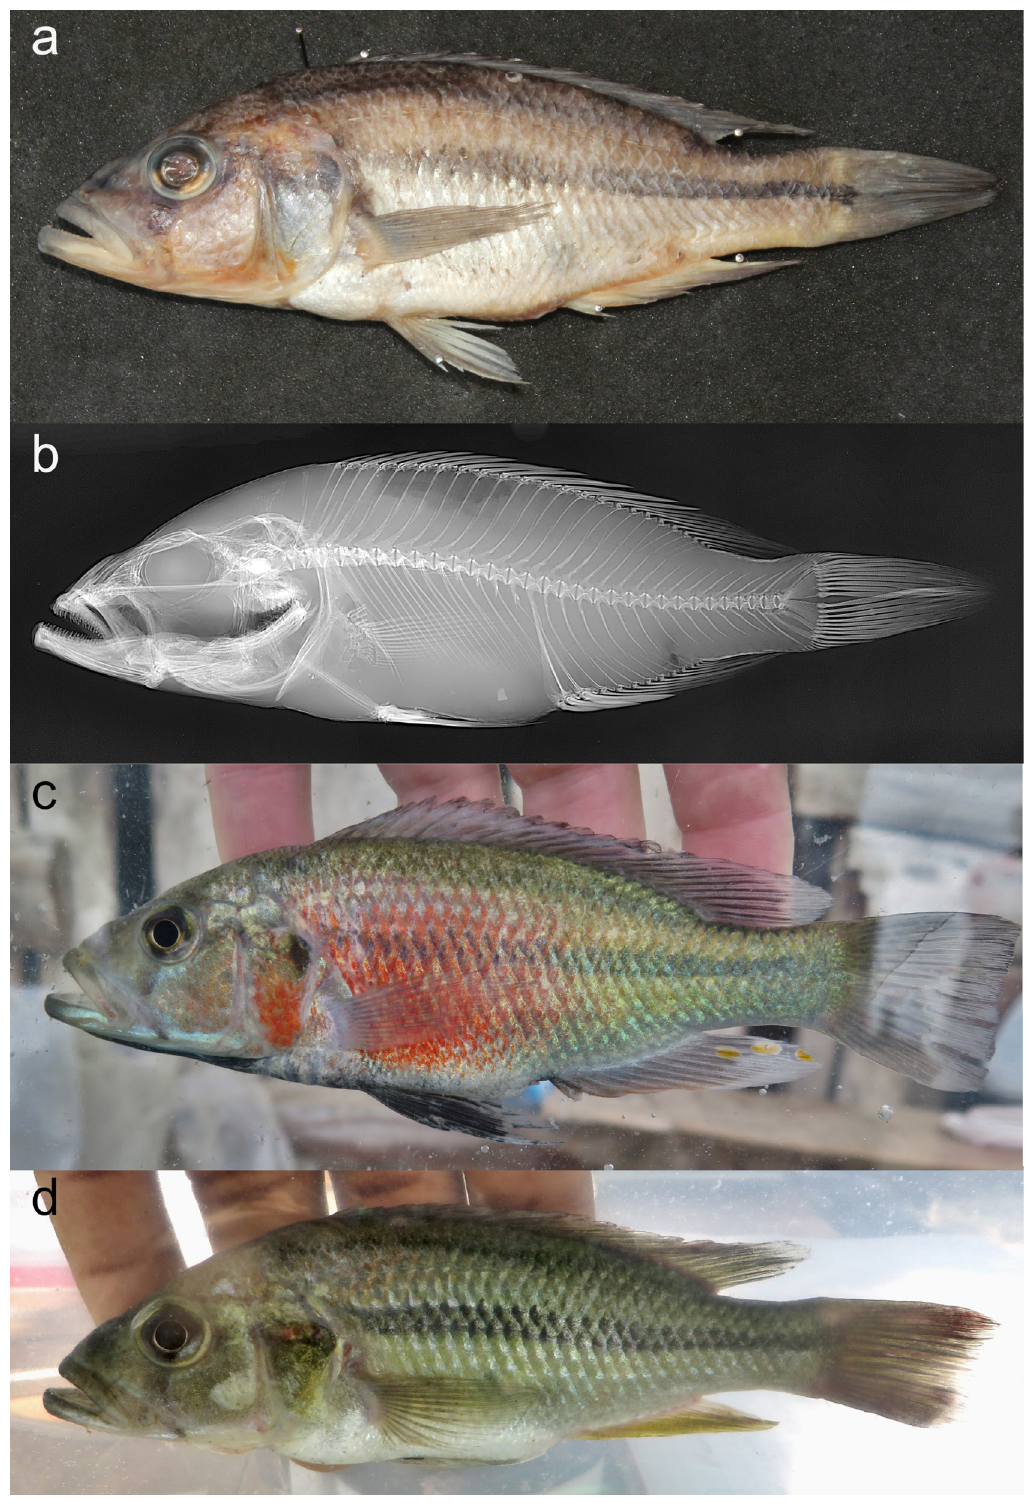
Fig. 27. Haplochromis falcatus sp. nov. a . Photograph of preserved holotype (RMCA 2018.008.P.0401; 101.3 mm SL). b . X-ray image of holotype. c – d . Photographs of freshly caught specimens. c . Dominant male (RMCA 2017.006.P.0416; 119.1 mm SL). d . Female (RMCA 2016.035.P.0257; 112.8 mm SL) to illustrate the live colour patterns. The contrast was slightly